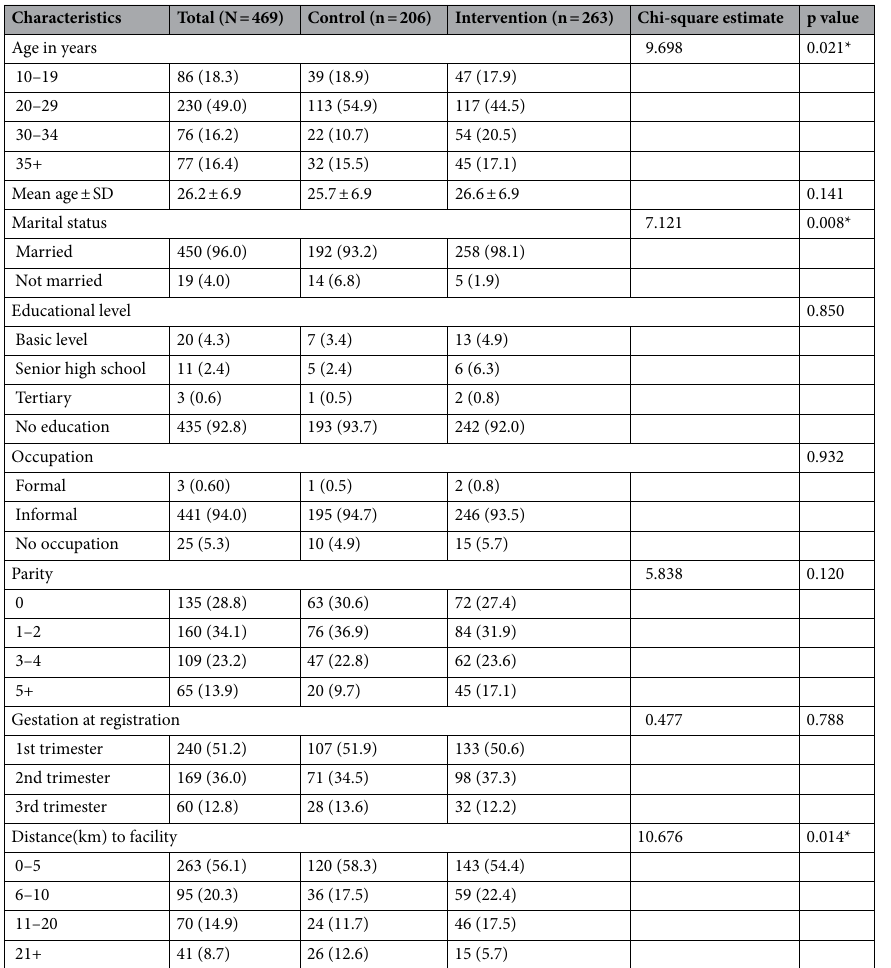
Table 1. Sociodemographic characteristics of the intervention and comparison groups. p value notation: ***p < 0.001, **p < 0.01, *p < 0.05.